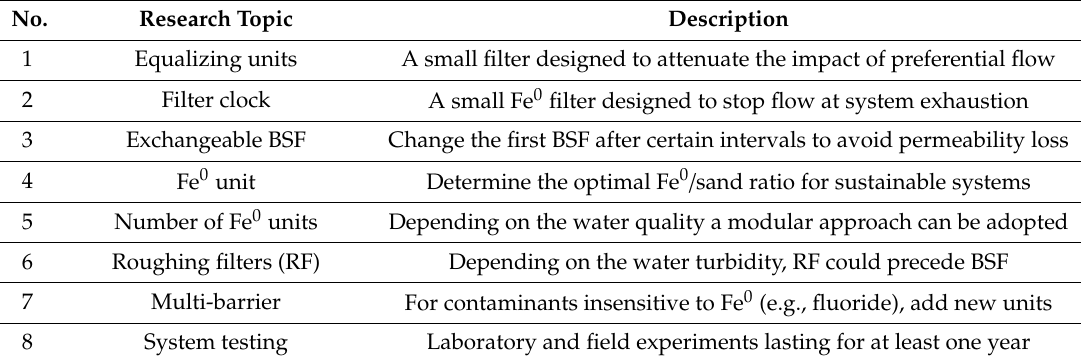
Table 3. Suggestions for future research on designing compact Fe 0 -based